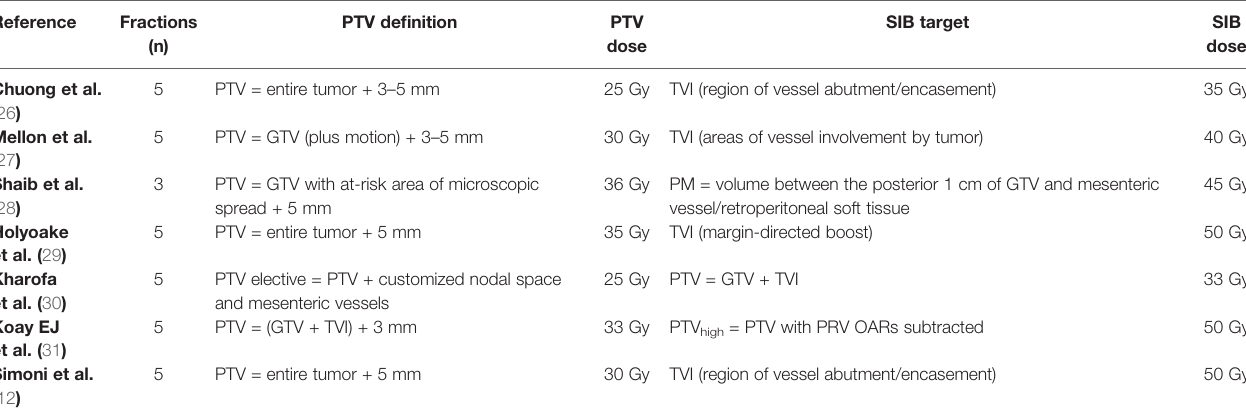
TABLE 5 | Studies using SBRT with Simultaneous Integrated Boost (SIB) for pancreatic cancer.